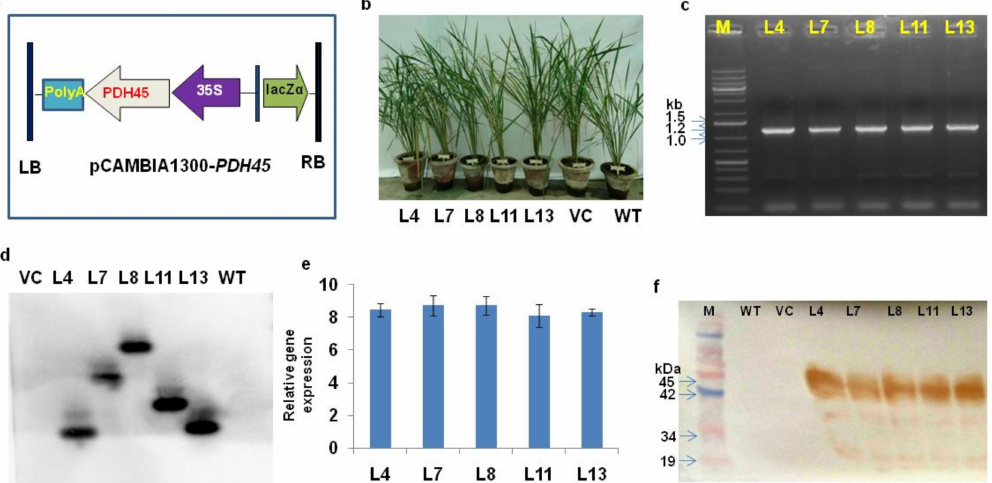
Figure 1. Screening and analysis of PDH45 marker-free transgenic lines. ( a ) T-DNA construct of pCAMBIA 1300- PDH45. ( b ) Transgenic lines (L4, L7, L8, L11, L13, VC, and WT). ( c ) PCR conforma- tion of the PDH45 -overexpressing transgenic (T 1 ) lines showed the amplification of 1.2 Kb fragment. ( d ) Southern blot analysis showing the integration and copy number of the PDH45 gene. ( e ) Rel- ative gene expression of PDH45 transgenic lines. ( f ) Western blot analysis showing the PDH45 protein ( ≈ 45 kDa).